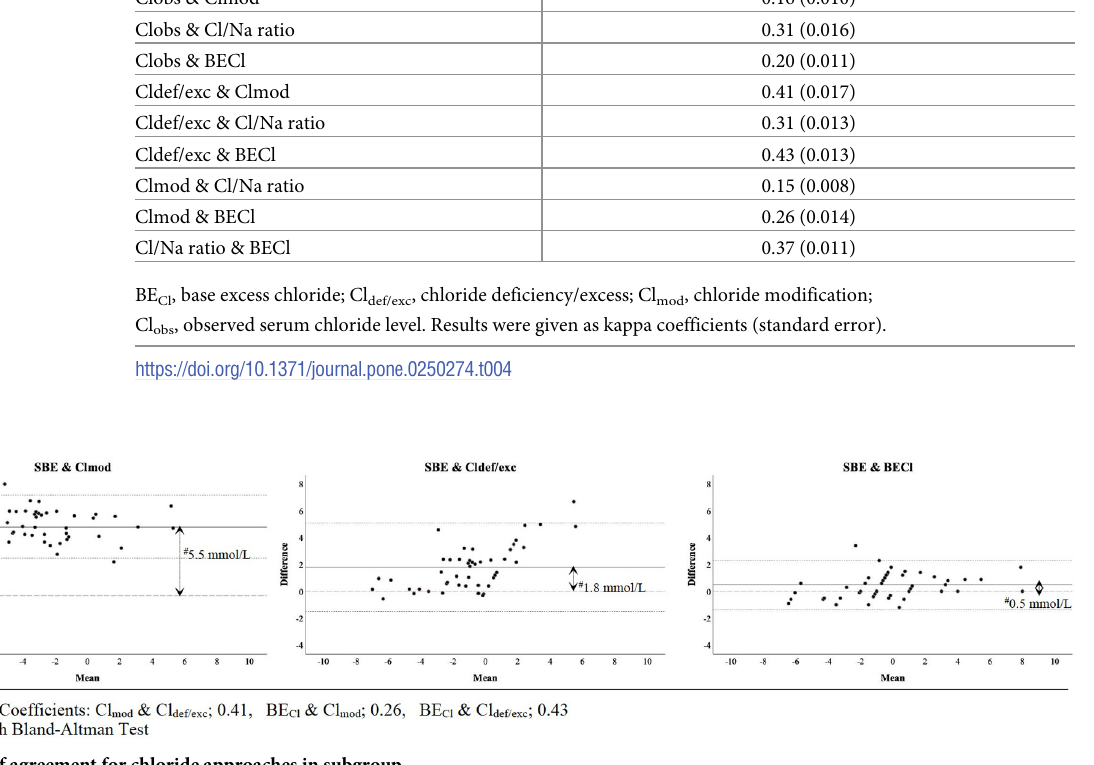
Fig 2. Limits of agreement for chloride approaches in subgroup.